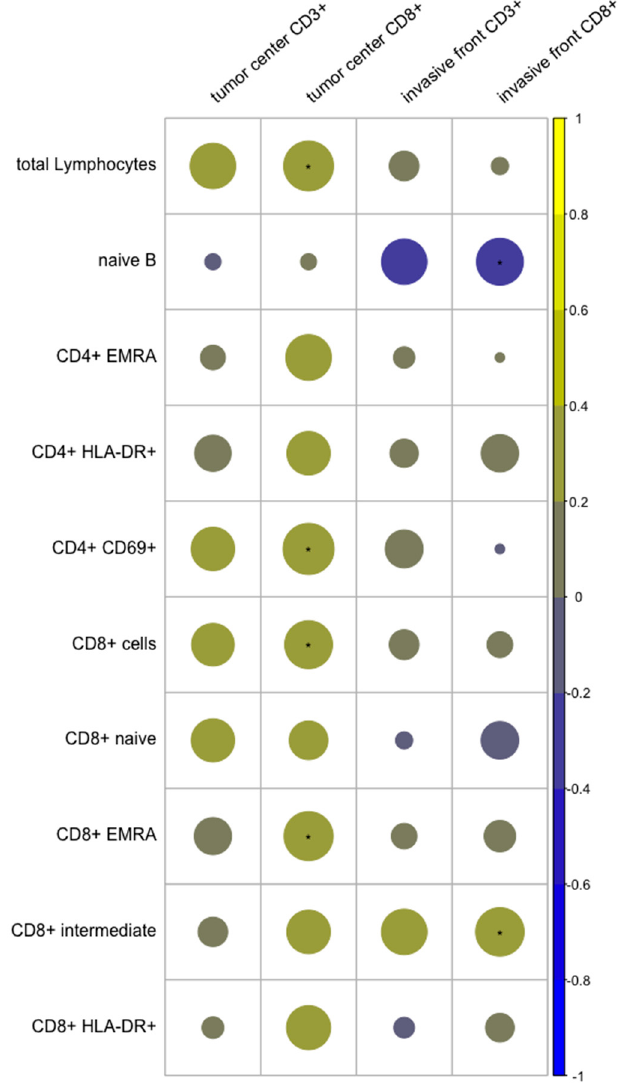
Figure 5. Correlation of tumor-infiltrating and selected circulating lymphocytes. Correlation coeffi- cient on the right side. Positive correlations are displayed in yellow and negative correlations in blue. Asterisks mark significant correlations.